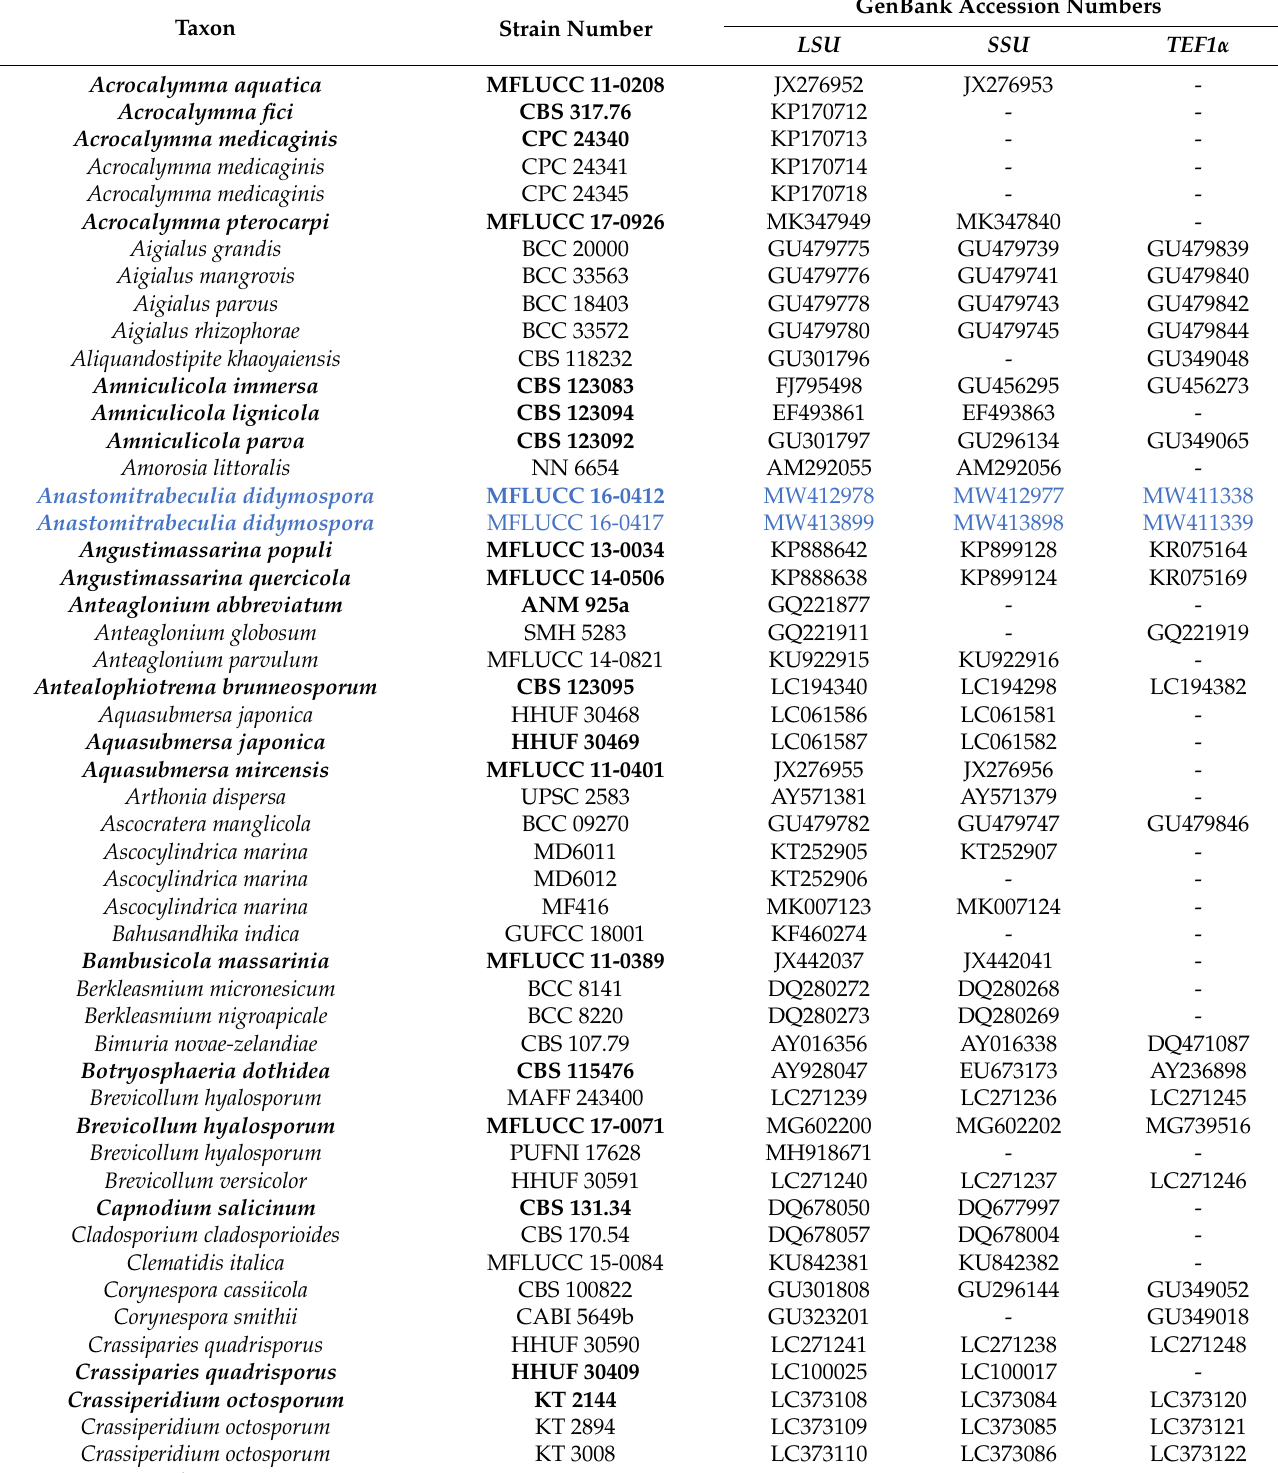
Table 1. DNA sequences and GenBank numbers used for the phylogenetic analyses in this study. The ex-type strains are in bold and the new taxon introduced in this study is indicated in